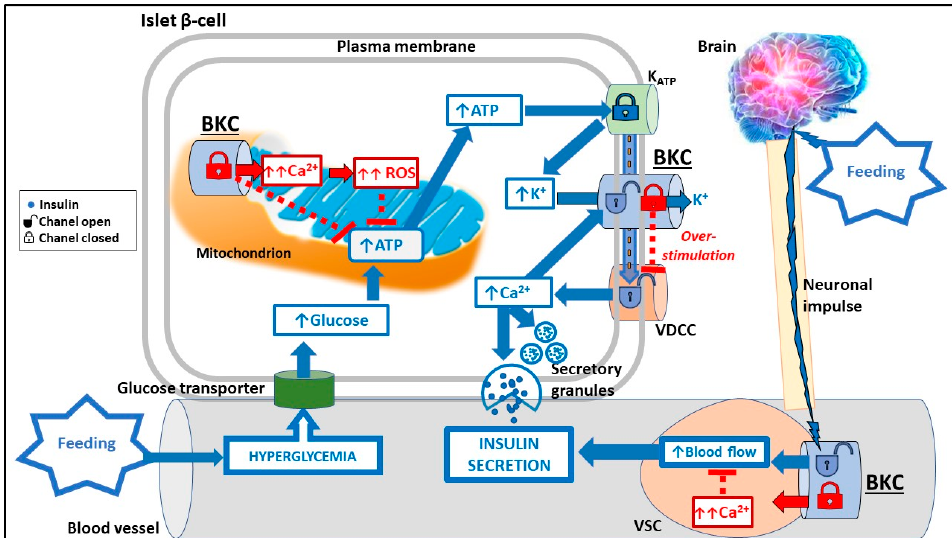
Figure 1. Simplified schematic representation of the effects of BKC inactivation in pancreatic β -cells. The inhibitory role of BKC inactivation (depicted in red) on some physiological mechanisms of insulin secretion (depicted in blue) evoked by hyperglycemia and autonomic impulses. Please see text for further details.